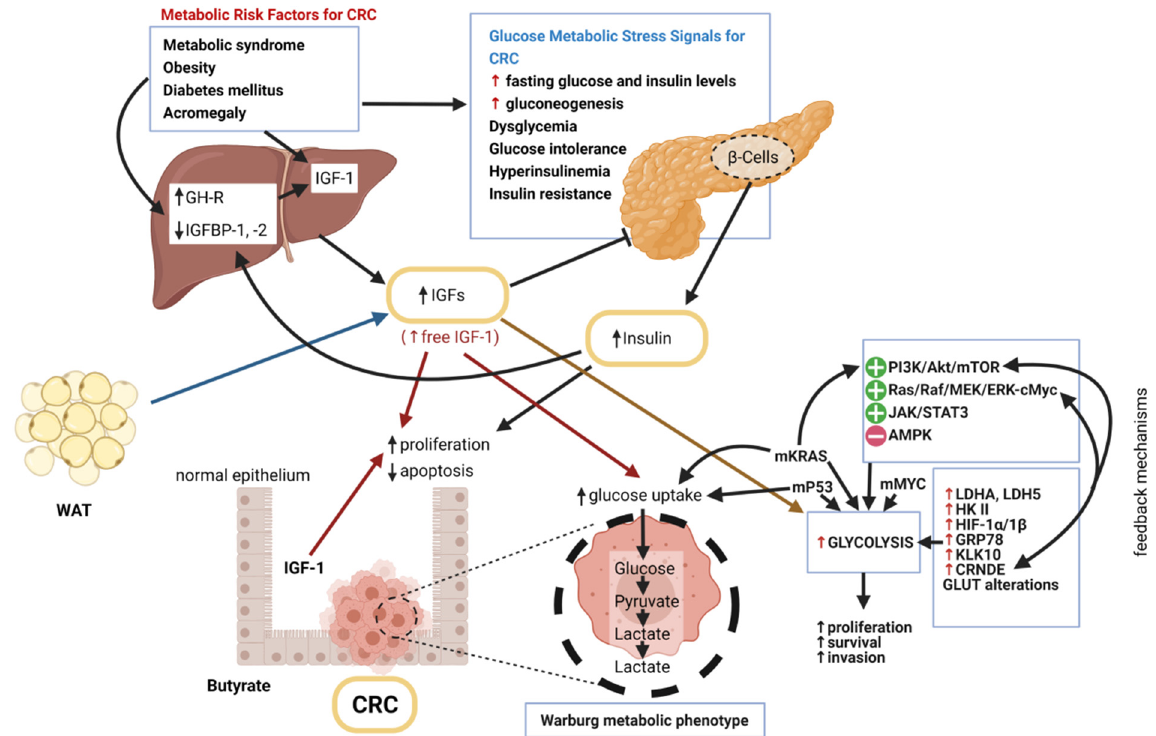
Figure 1. Schematic illustration of the insulin/IGF-1 system involved in the development and progression of colorectal cancer (CRC) through direct (mitotic effects) and indirect (aerobic glycolysis) activity. [ ↑ , ↓ -increase (up-regulation)/decrease (down-regulation) expression/level; AMPK-adenosine monophosphate (AMP)-activated protein kinase; CRNDE-colorectal neoplasia differentially expressed gene; GLUT-glucose transporter; GH-R-growth hormone receptor; GRP78-glucose-regulated protein 78; HIF-1 α , - β -hypoxia-inducible transcription factor-1 α , - β ; HK II-hexokinase II; IGF-1-insulin-like growth factor 1; IGFBP-1;-2-IGF binding proteins 1,-2; JAK/STAT3-Janus kinase/signal transducer and activator of transcription; KLK10-kallikrein-related peptidase; LDHA, -5-lactate dehydrogenase A, -5; mKRAS-mutant KRAS gene; mMYC-mutant MYC gene; mTP53-mutant tumor protein 53 gene; PI3K/Akt/mTOR-phosphatidylinositol 3 ki- nase/Akt/mammalian target of rapamycin complex; WAT-white adipose